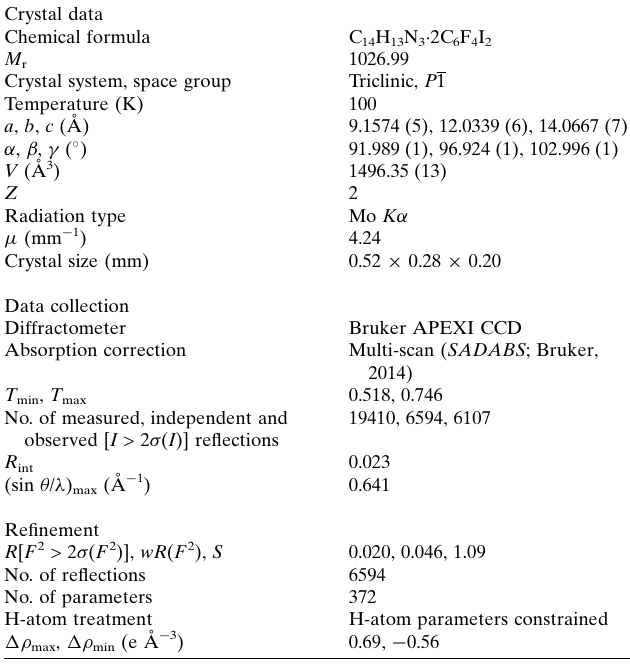
Crystal data Chemical